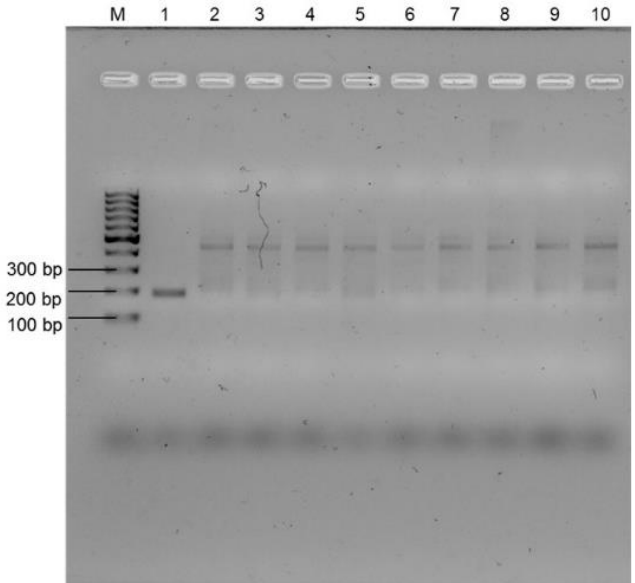
Figure 3. Specificity validation of Ent F1/R1 primer set using RPA-AGE. Lane M: 100 bp molecular marker, Lanes 1 to 10: E. faecalis , E. faecium , Staphylococcus aureus , Streptococcus pneumoniae , Bacillus cereus , Pseudomonas aeruginosa, E. coli O157:H7 , Salmonella t yphimurium, Shigella dysenteriae, E. coli K -